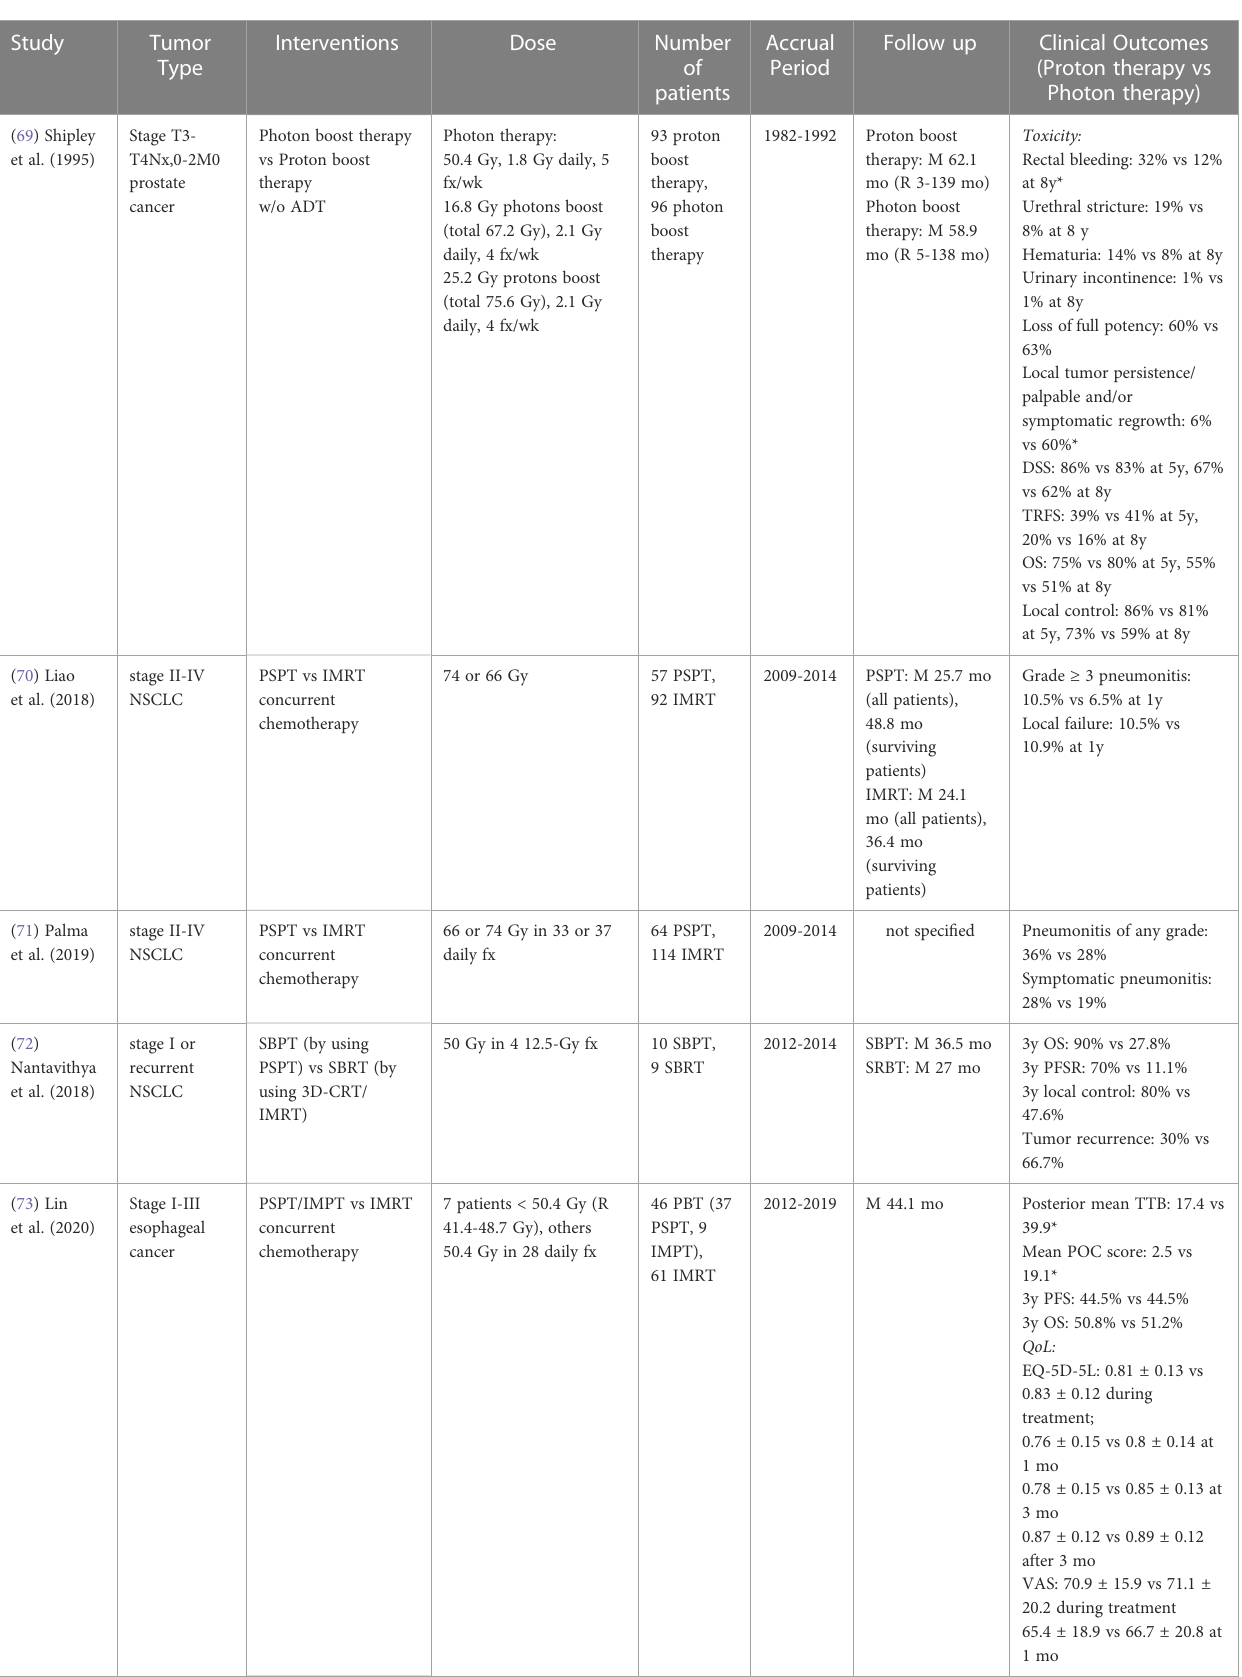
TABLE 8 Randomized clinical studies of proton versus photon radiation